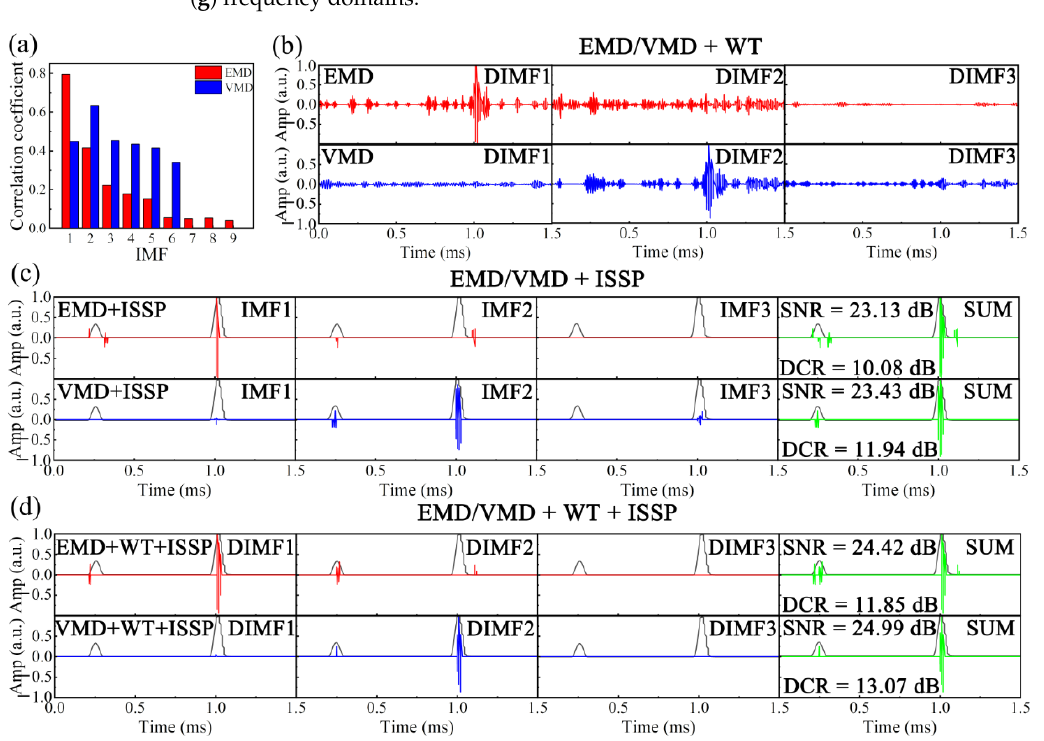
Figure 11. ( a ) Correlation coefficients of IMFs, processing results of ( b ) E/VMD + WT, ( c ) E/VMD + ISSP, and ( d ) E/VMD + WT + ISSP.